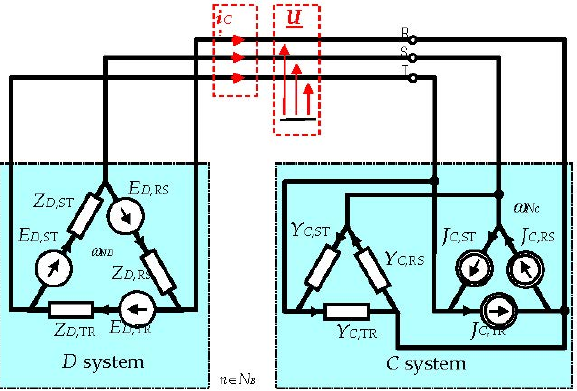
Figure 7. Cooperation of a non-linear three-phase receiver with a real source in the situation of com- mon harmonics in E D and J C sources.